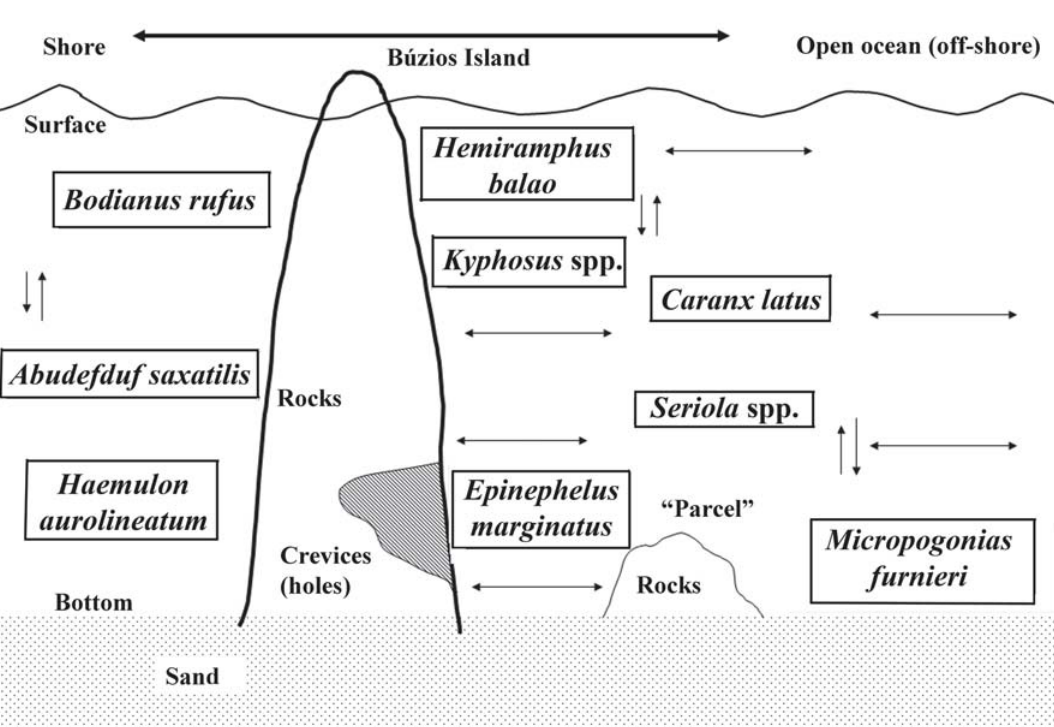
Fig. 3. Main habitats of fishes according to fishermen in the southeastern Brazilian coast: percentages of fishermen who mentioned each habitat category are in Appendix 1. Double-headed arrows indicate that fishes occur in both habitats in horizontal space ( e.g. open ocean and reefs), up and down arrows indicate that fishes occur in both habitats in vertical space ( e.g. , near the bottom and at the surface). Fish sizes are not in